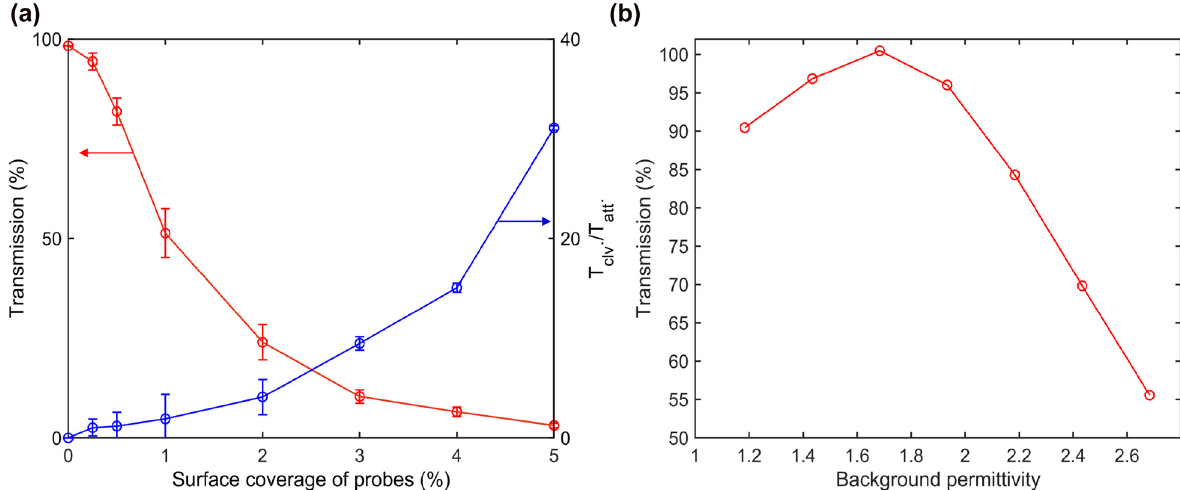
Figure 7: Sensitivity of the optimized integrated waveguide-based biosensor. (a) Transmittance of the optimized integrated waveguide-based biosensor with different surface coverage of nanoparticle probes. Five different distributions of the probe positions have been simulated and the transmittance value averaged over different configurations to create one data point in this plot. The blue curve indicates the transmission contrast (expressed as the ratio of transmittances) between the ‘probes attached’ and ‘probes cleaved’ states. The error bars indicate a standard deviation of transmissions at the five different distributions of the probes. (b) Transmittance versus background permittivity of the optimized waveguide-based biosensor. Small variations of the aqueous solution permittivity have a much smaller effect on the biosensor transmittance than the presence of the nanoparticle probes on the sensor